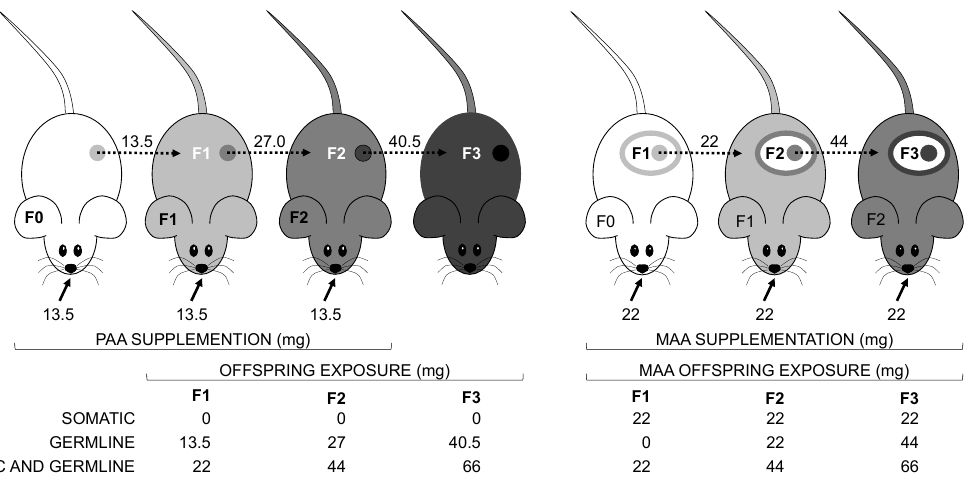
Figure 2. Cumulative germline and/or somatic offspring AA exposure of paternally and maternally supplemented mice. Filled arrows indicate total mg of AA supplement (calculated by multiplying mg of daily supplement by days of exposure) administered at each generation (F0, F1, and F2); dotted arrows indicate milligrams of germline or soma AA exposure (circles and ovals, respectively) of F1, F2 and F3 offspring generations. Cumulative AA exposure somatic and/or germline offspring exposure at each generation are indicated below each mouse generation. Similar calculations were performed of paternal and maternal vehicle supplements.